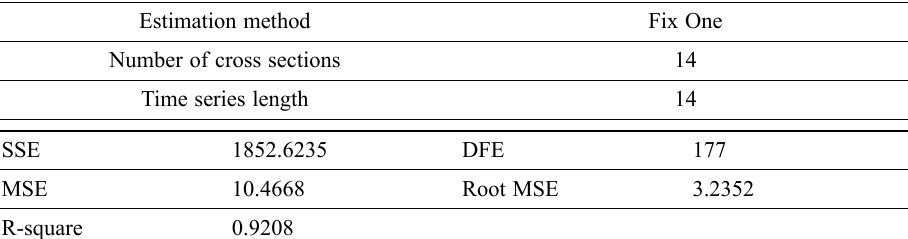
Table 3. One way fixed model, value as dependent variable